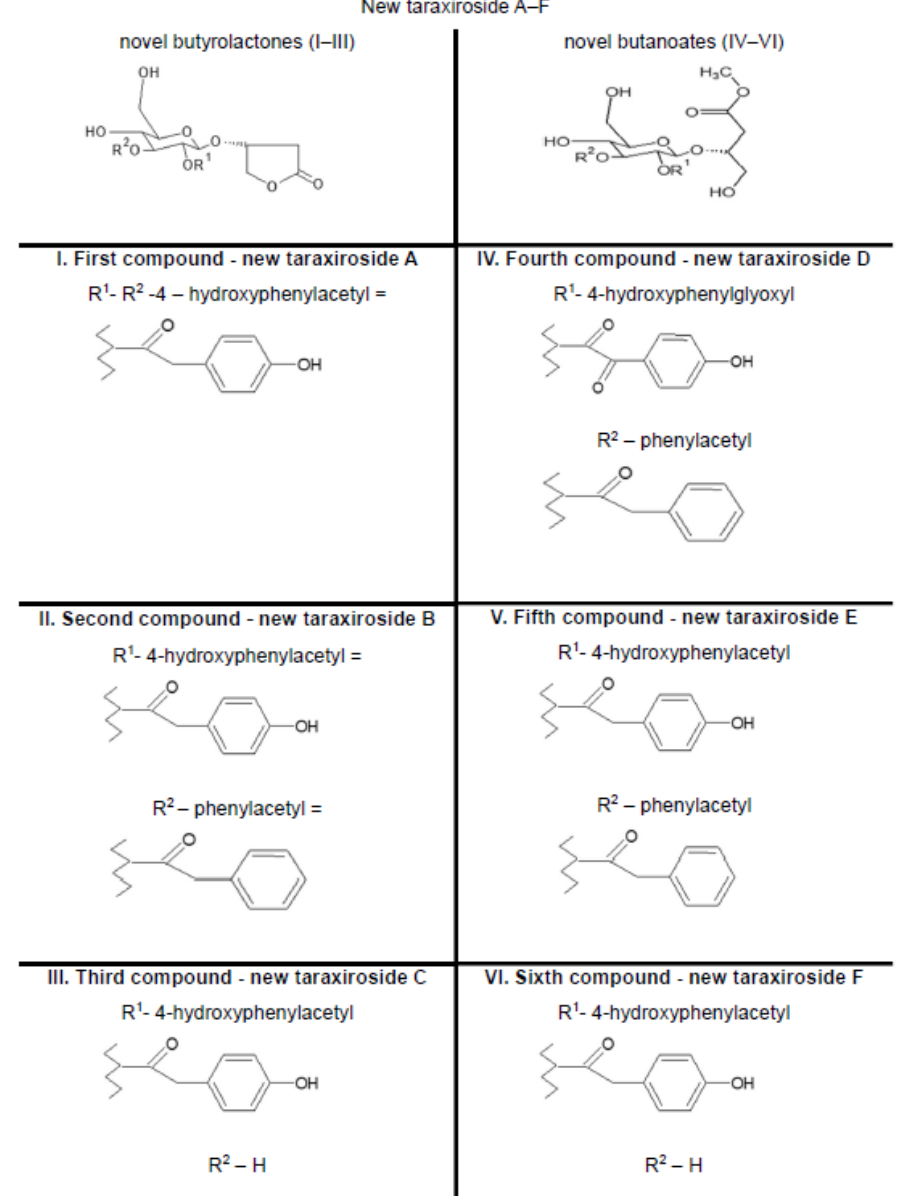
Figure 3. New compounds isolated from Taraxacum officinale Choi et al. 2018 [49].